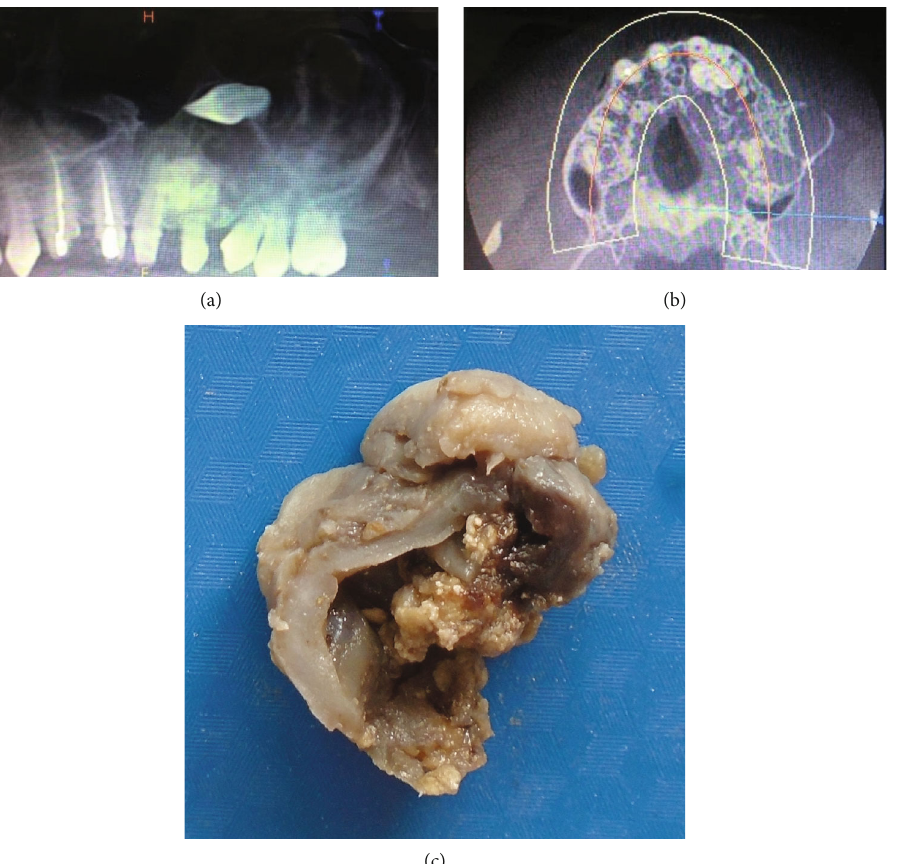
Figure 2: (a) OPG showing impacted canine and radioopaque odontome-like lesion in 23 and 24 regions. Large well-demarcated multilocular lesion irt 24, 25, and 26 regions associated with root resorption. (b) Axial CT scan shows multilocular lesion in the maxillary posterior quadrant with expansion of buccal plate and radio dense lesion irt 23 region. (c) Grossing shows a thick cystic wall with a thick capsule. In the cystic lumen, white gritty areas were